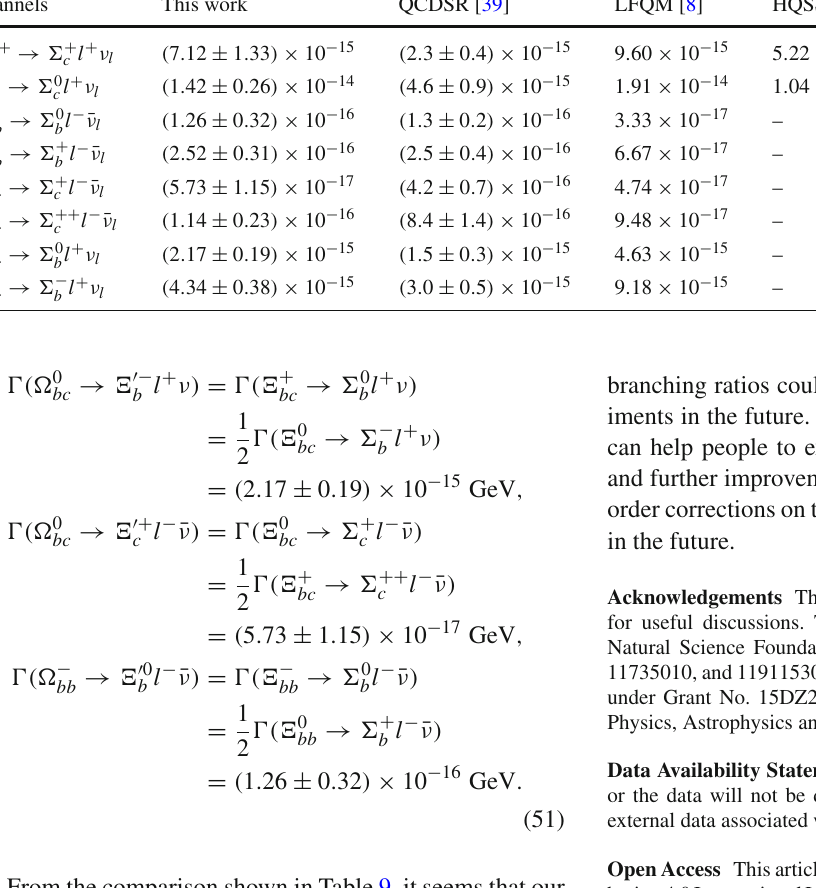
Table 9 Comparison of the decay widths (in units of GeV) for the the heavy quark spin symmetry (HQSS) [51], the nonrelativistic quark semi-leptonic decays in this work with the results derived from QCD model (NRQM) [48] and the MIT bag model (MBM) [48] in literatures sum rules (QCDSR) [39], the light-front quark model (LFQM) [8], Channels This work QCDSR [39] LFQM [8] HQSS [51] NRQM [48] MBM [48]